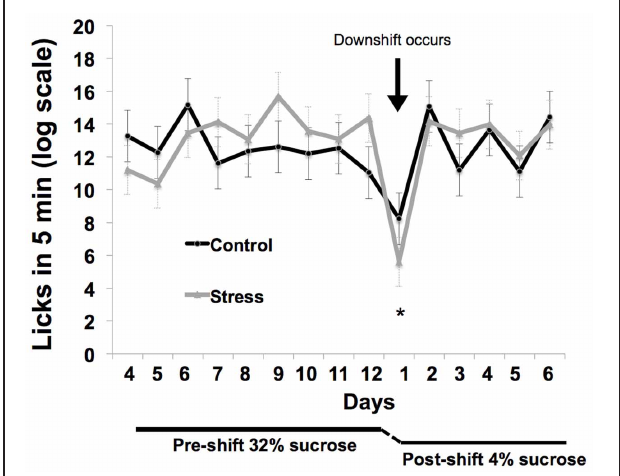
FIGURE 4 | Coping response in a successive negative contrast test following stress during adolescence. Animals exposed to chronic unpredictable stress during adolescence exhibited a long-term increase in reward loss sensitivity as measured by successive negative contrast (SNC). The asterisk indicates a significant difference in the downshift scores between the adolescent-stressed and control animals.